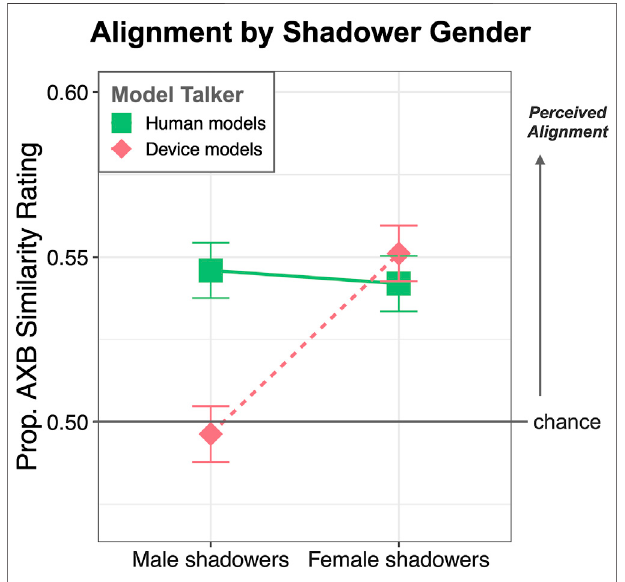
FIGURE 2 | Mean proportion and standard errors of AXB perceptual similarity ratings for the interaction between Model Talker Humanness (Device vs. Human) and Shadower Gender (F,